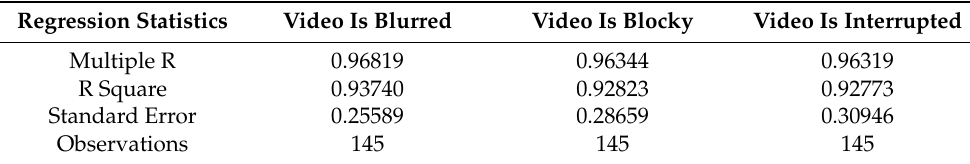
Table 10. The summary output for the video group of degradations.